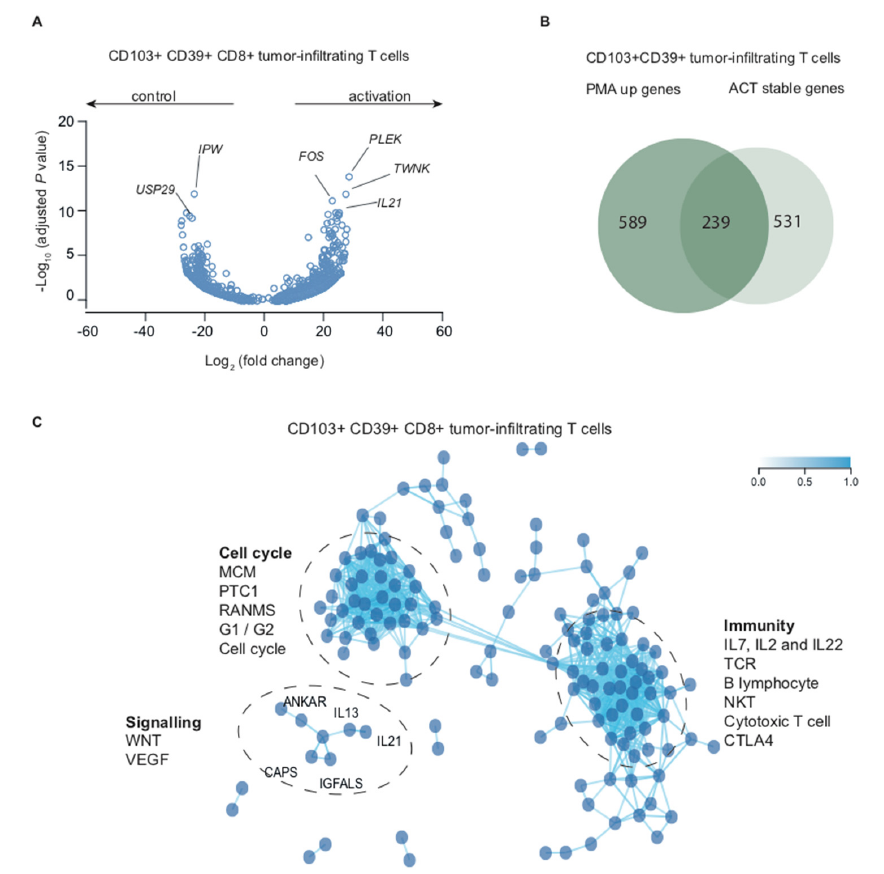
Figure 3. CD39+CD103+ T RM cells differentially upregulate genes associated with immunity, cell cycle, and the tumor microenvironment. ( A ) Volcano plot depicting differentially expressed genes (DEseq2) of CD39+CD103+ T RM cells treated with PMA/ionomycin for four hours versus untreated cells. Each dot represents a gene with a Benjamini–Hochberg adjusted p -value < 0.05. ( B ) Venn diagram showing overlap of differentially expressed genes of PMA/ionomycin-treated CD39+CD103+ T RM cells and significantly stable genes after actinomycin D treatment. ( C ) Co-functionality network of the top-250 differentially expressed genes in PMA/ionomycin-treated cells versus untreated CD39+CD103+ T RM cells with default parameters. Several Biocarta pathways with z-score > 2 are annotated.